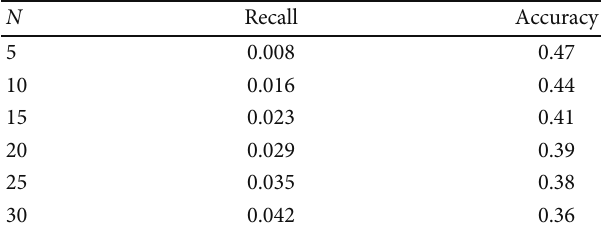
Table 3: Accuracy and recall of all characters recommended. N